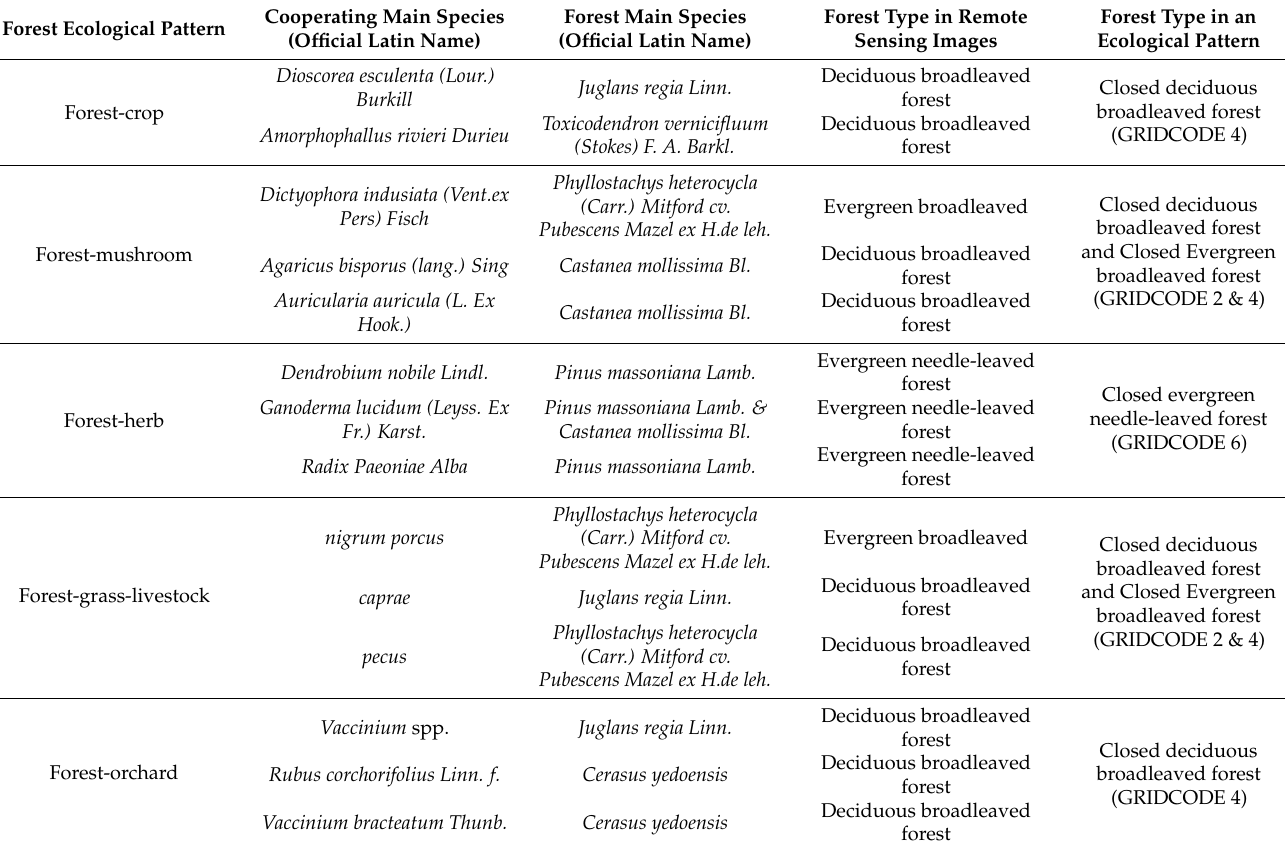
Table 2. Corresponding information of forest ecological patterns and forest types in Hefei.